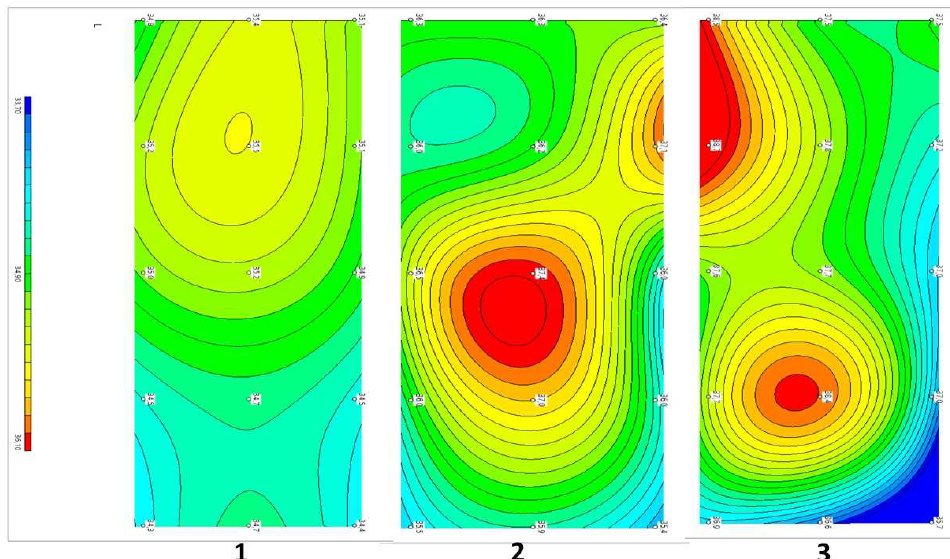
Figure 5. Dynamics of temperature fields in the lumbar region in patient P against the background of standard treatment. ( 1 ) Healthy volunteers, mean data, n = 31. ( 2 ) Patient P, before treatment. ( 3 ) Patient P, after treatment. Note: On the left, the fields of internal temperatures, from left to right indicate L1 to L5 (in the center in the projection of the spinous processes; above and below, paravertebral 30 mm from the center); on the right, thermograms at 15 measurement points. Compared with the symmetric temperature field of the control group (1) before treat- ment, in patient P...a (2), zones of increased temperature were visualized in the L2 projec- tions on the right, paravertebral, and L3–4 above the spinous processes. The ΔТ = Tmax − Tmin depth temperature before treatment was 2.0 ° C and that of the skin was 2.7 ° C. After treatment (3), the asymmetry did not disappear. There were zones of increased tem- perature in the L1–2 projection on the left paravertebral area, and elevated temperature in the L5 projection in the center. As we can see from this example, the decrease in pain according to the VAS from five to two points in this patient with traditional treatment did not correlate with temperature asymmetries or temperature normalization. Example 2: Patient I...in, 56 years old. Diagnosis: Dorsopathy of the lumbosacral spine, lumbodynia, and muscle-tonic syndrome. Concomitant diagnosis: Arterial hyper- tension in the first stage. Recurrent low back pain for more than 30 years. The duration of the current exacerbation was three days. The pain localized in the lumbar region, subjec- tively in depth, paravertebrally on the left in the projection L1–2. There were no neuro- logical deficits. The symptoms of tension were negative. Complex therapy with the addi- tion of eight sessions of SCENAR therapy VAS before treatment was six points, and after three weeks of treatment was two points. The dynamics of changes in temperature fields and thermograms are shown in Figure 6.